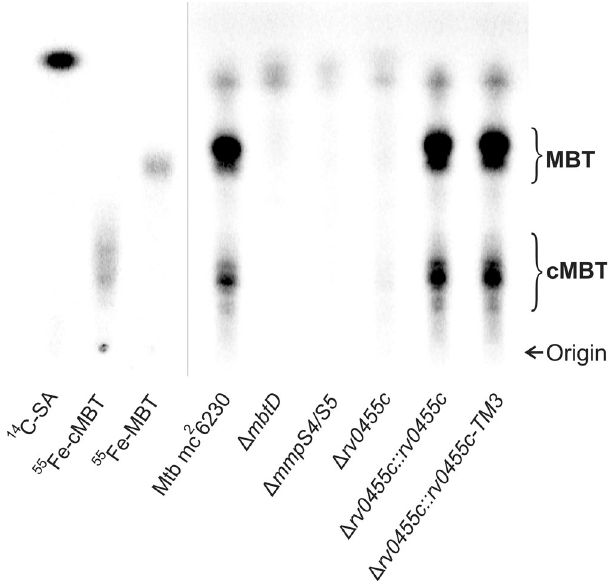
Fig. 3 Rv0455c is required for siderophore secretion by M. tuberculosis . Thin-layer chromatography of chloroform-extracted siderophores from the culture fi ltrates of the M. tuberculosis mc 2 6230 parent strain, the siderophore biosynthetic mutant Δ mbtD , the siderophore secretion- defective mutant Δ mmpS4/mmpS5 , the Δ rv0455c mutant and the Δ rv0455c mutant complemented with integrated rv0455c and rv0455c-TM3 expression vectors. The siderophores were labeled with [7- 14 C]-salicylic acid (SA), which was loaded on the silica gel plate as a control together with 55 Fe-carboxymycobactin (cMBT) and 55 Fe-mycobactin (MBT). A mixture of ethanol/cyclohexane/water/ethyl acetate/acetic acid with the volume ratios of 5:25:2.5:35:5 42 was used as a solvent. The loaded samples were normalized to their OD 600 at the time of harvest of the bacterial cultures. Data were obtained from at least two independent experiments and representative images are shown. Source data are provided in the Source Data fi